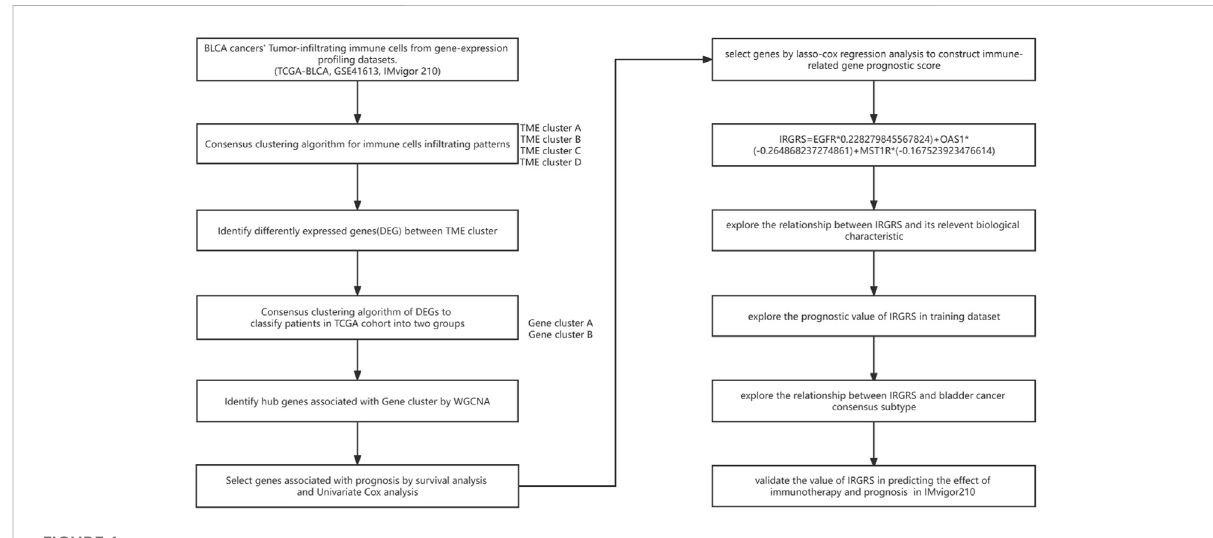
FIGURE 1 Overview of work fl ow about the study